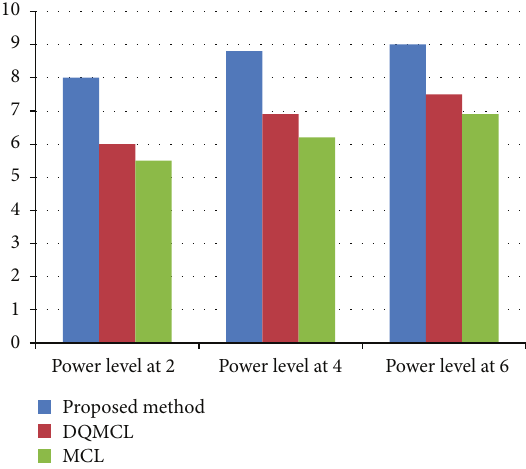
Table 4: Experimental measurement of RSSI value with distance.